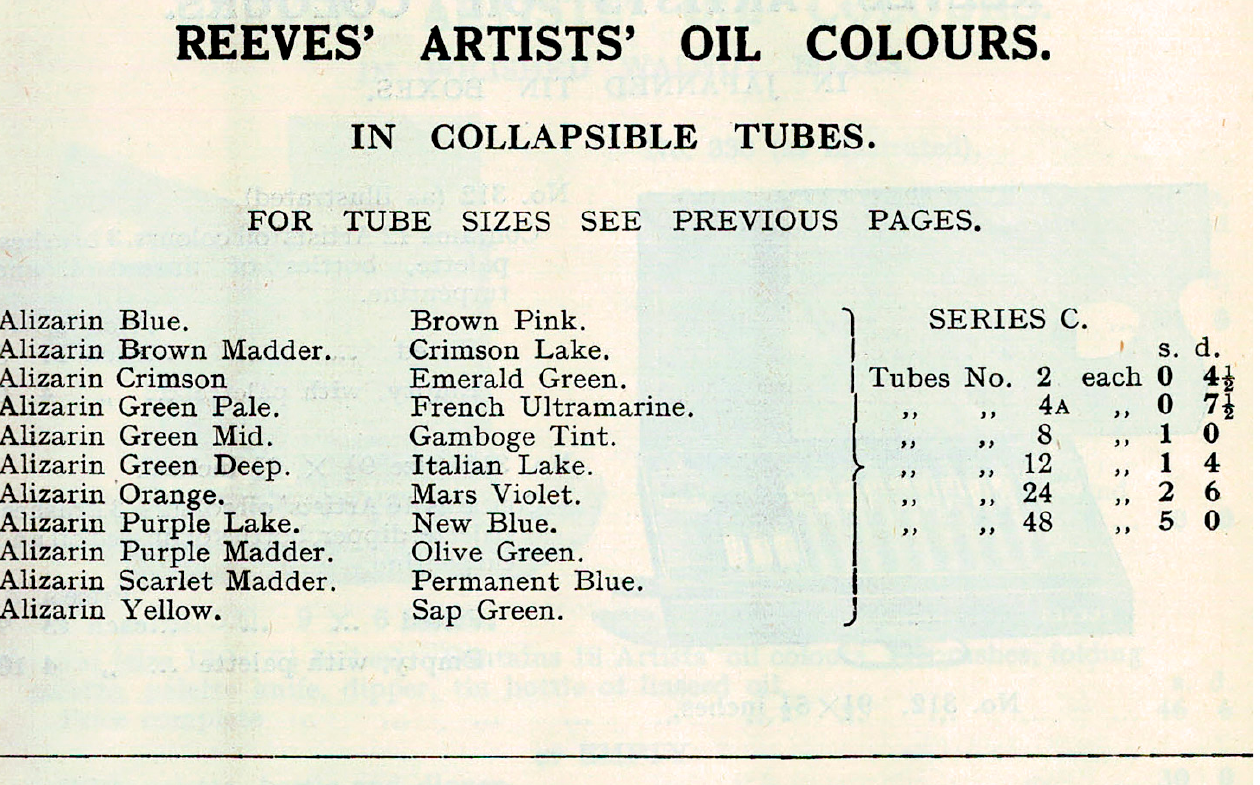
Figure A1. Selected pigment compositions, listed in the catalogue of W&N from 1934.